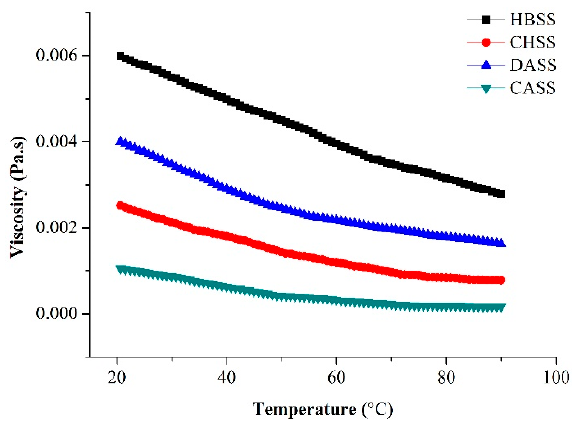
Figure 4. E ff ect of apparent viscosity of 1% MLPs with rising